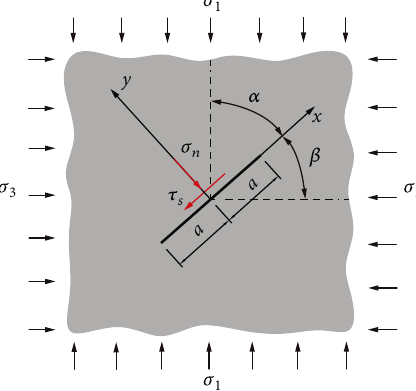
Figure 4: Full-closed crack subjected to compression.